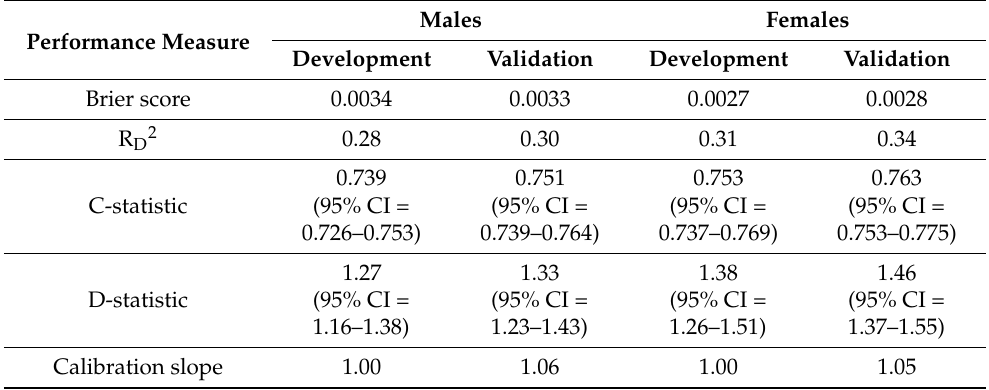
Table 3. Performance measures of the joint models.